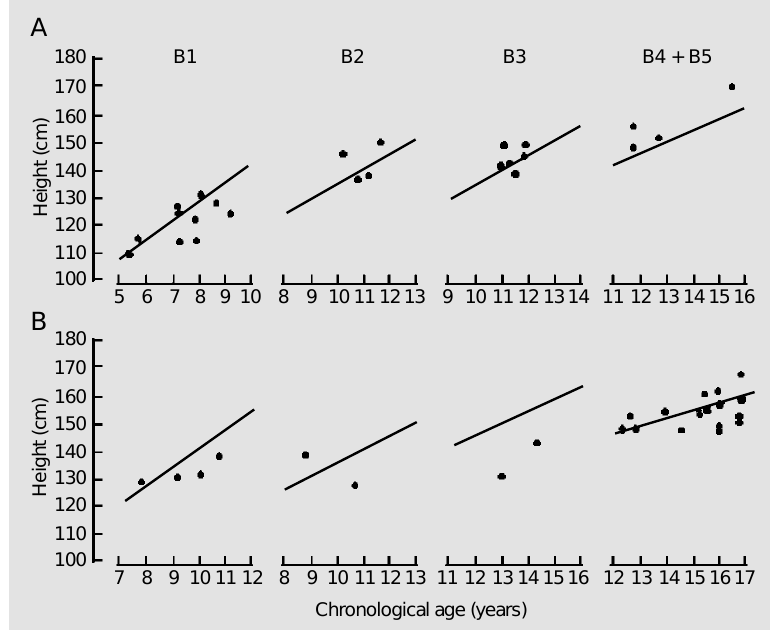
Figure 1. Height in relation to age and pubertal stage (Tanner’s classification; B1 to B4 + B5) at diagnosis (A) and at final evaluation (B) in type 1 diabetic girls. B1-B5: breast develop- ment.